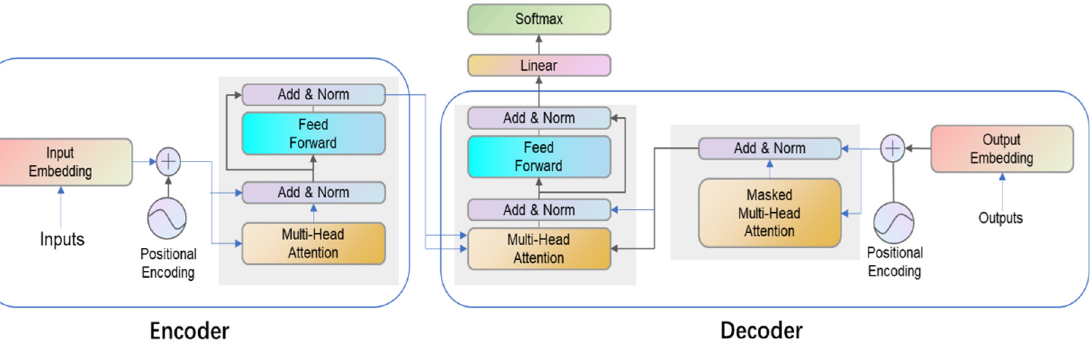
Figure 3. The architecture of the basic Transformer.